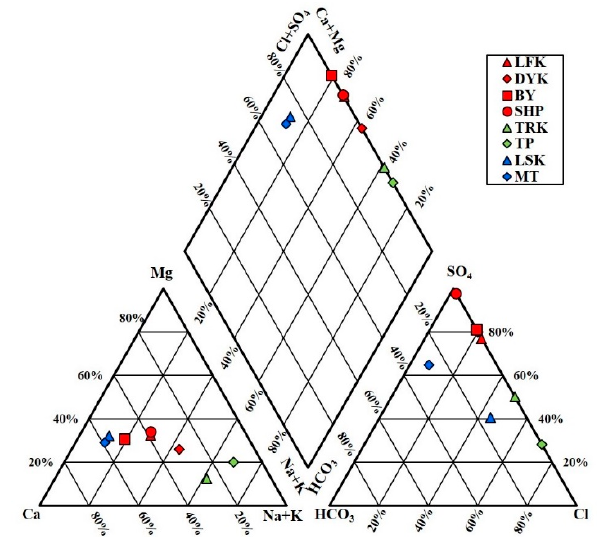
Figure 3. Piper diagram of the Tatun geothermal field hot spring waters. To investigate the spatial distribution of the thermal water in the TVG, we generated contour maps of temperature and pH for the years 2009, 2010, and 2011, using the inverse distance weighted method (IDW), as shown in Figures 4 and 5. The maps show that the middle of the TVG (near HS and ◦ LSK), had an average pH of 6 and an average temperature of 44.5 C. In the northeast and southwest ◦ sides of the TVG, the average pH was 2.2 and 1.3, and the average temperatures were 65.2 C and ◦ 60 C, respectively. In general, the thermal water in the central part of the TVG was neutral with lower temperatures. In contrast, the thermal water in the northeast and southwest sides were acidic with higher temperatures. The contour maps of the temperature and pH were similar from 2009 to 2011, indicating that the distribution of temperature and pH was nearly constant. The results of the drill-hole data and 3-D geological modeling indicated that the heat source was located between the Mt. Chihsinshan and Tayukeng areas. There was a thick and impermeable andesite layer above the heat source, causing the thermal fluid to be transported towards a NE–SW direction [43]. The thermal